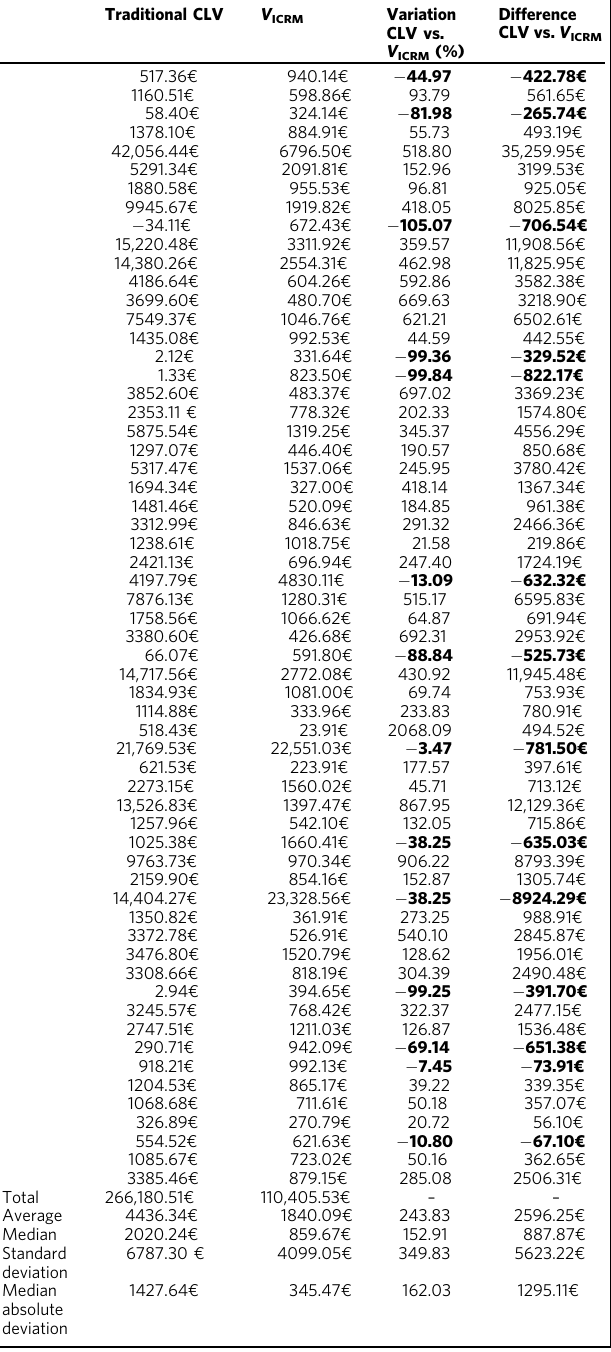
Table 9 Results in CLV and V ICRM models for the total sample.